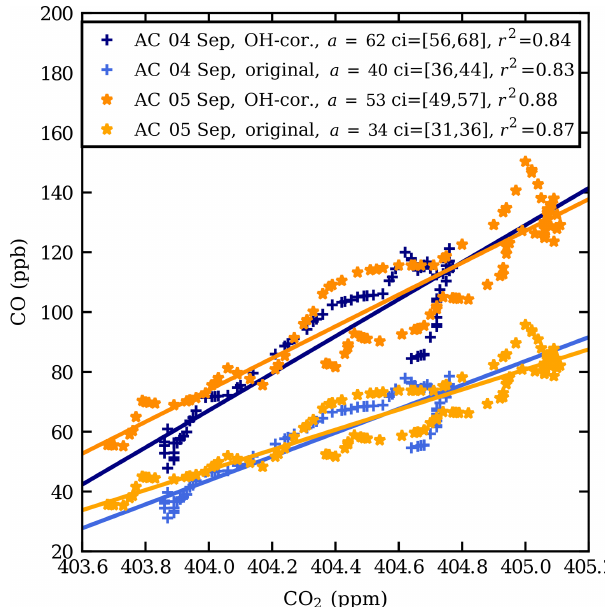
Figure 4. CO vs. CO 2 scatter plot at the observed CO enhancement in the AirCore (AC) profiles from 4 and 5 September 2017. The data shown are between the pressure levels 167 and 140hPa (13.2– 14.3km) on 4 September and between 175 and 140hPa (12.9– 14.4km) on 5 September. The lighter shades of orange and blue show the original values and the darker shades the CO values cor- rected for oxidation by OH. a is the fitted slope and ci is the 95% confidence interval of the fitted